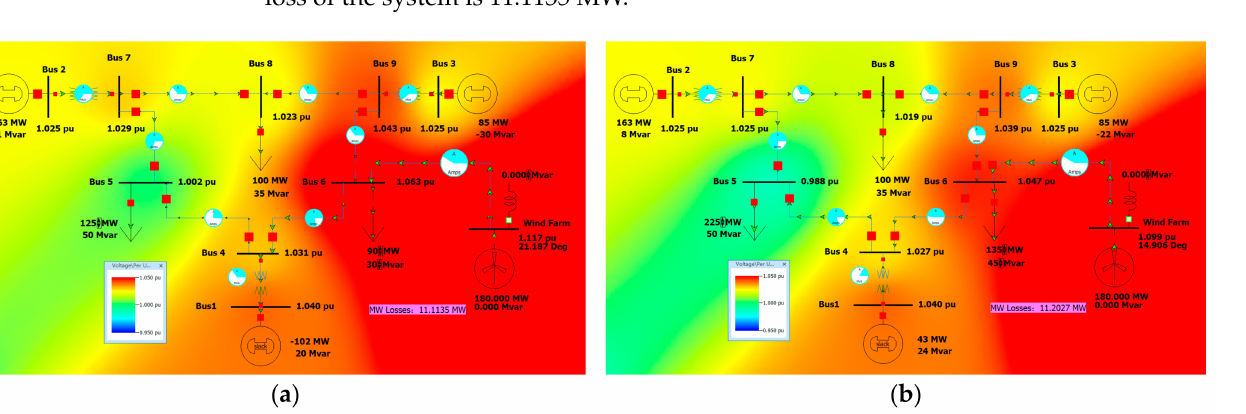
Figure 8. Simulation results with Tower C connected to bus 6 (300 km). ( a ) The results under the minimum load condition and ( b ) the results under the maximum load